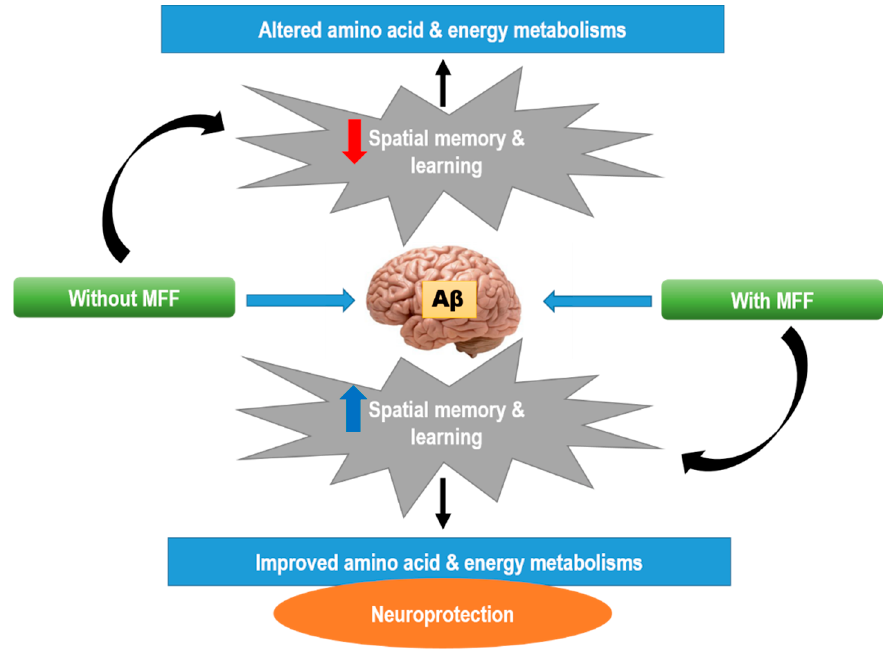
Figure 11. The possible neuroprotective mechanisms of MFF in A β -42-induced rats.